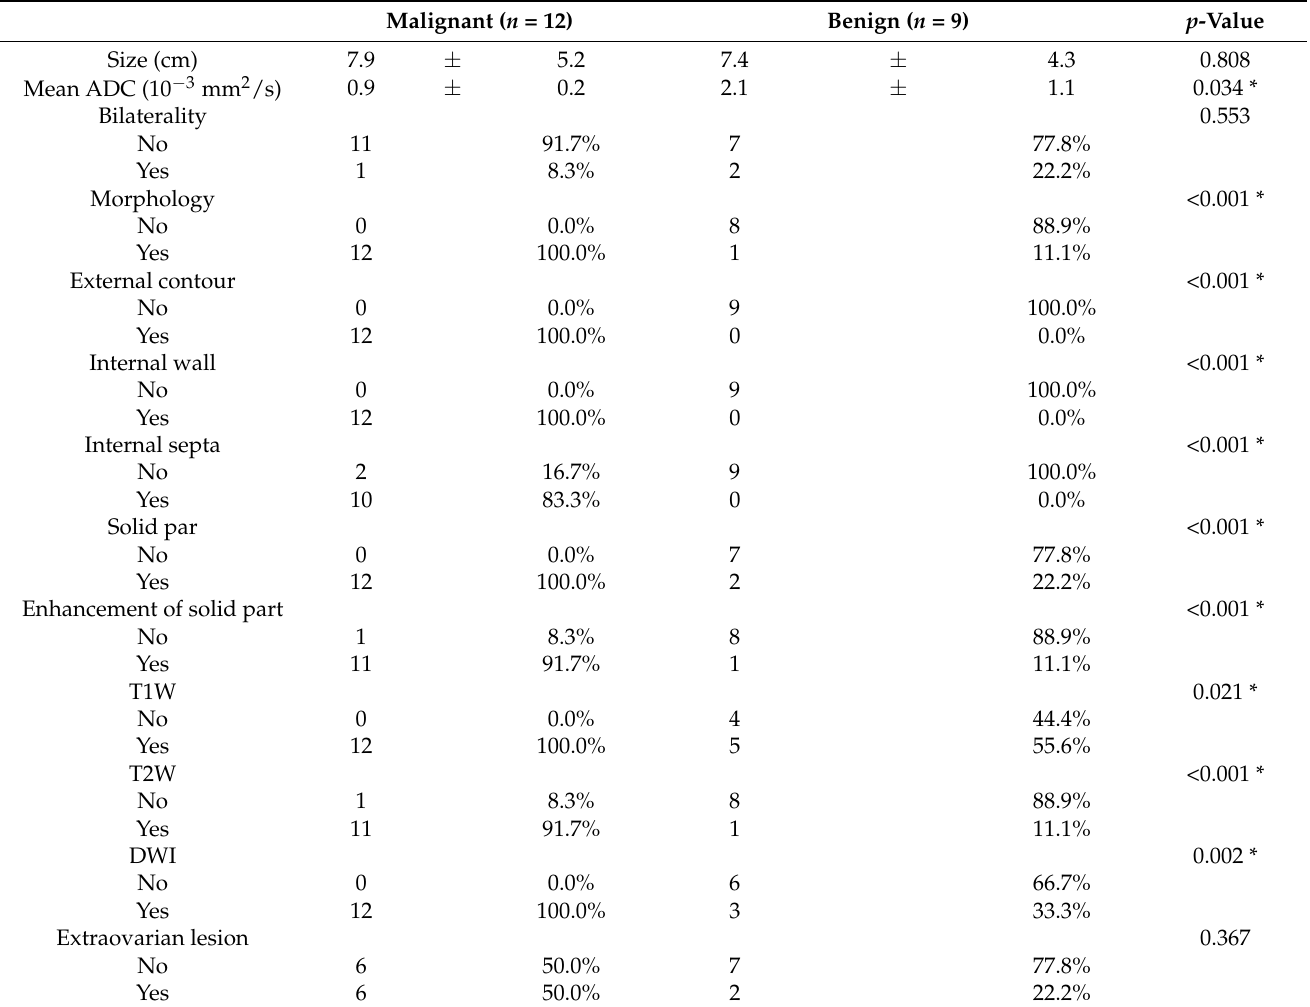
Table 2. MR imaging characteristics between malignant and benign ovarian